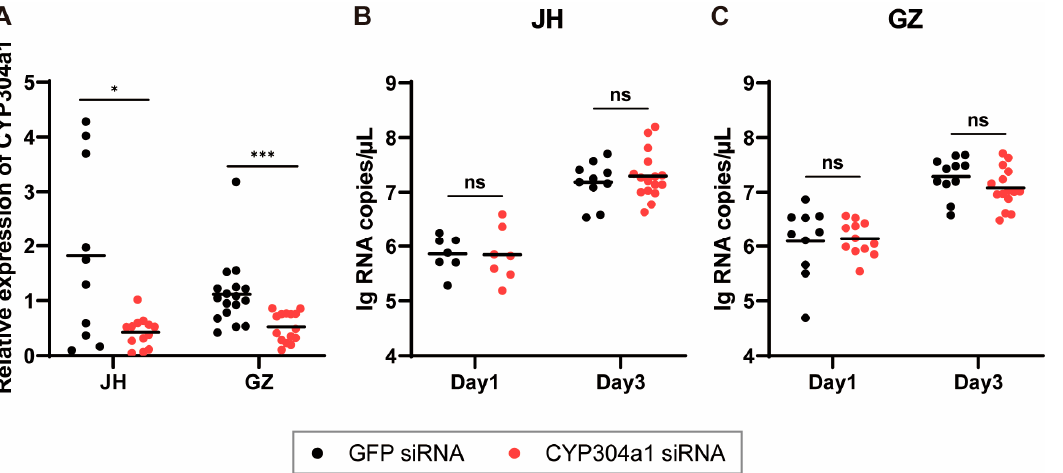
Figure 4. CYP304a1 silencing and ZIKV infection in Ae. albopictus . ( A ) Abundance of CYP304a1 after RNA interference. Mosquitoes were microinjected with GFP and CYP304a1 siRNA, and the relative expression of CYP304a1 in the mosquitoes was detected by RT-qPCR. One dot represents 1 mosquito, and the horizontal line represents the median of the results. Differences between two groups were compared by the non-parametric Mann–Whitney test. The siRNA knockdown efficiency of CYP3304 a1 in the JH and GZ strains was 65.5% and 53.5%, respectively. ZIKV RNA copies were in the Ae. albopictus JH ( B ) and GZ ( C ) strains. The ZIKV suspension was inoculated by thoracic microinjection at 3 days post-CYP304a1 silencing. The viral load was assessed at 1 and 3 dpi through RT-qPCR. One dot represents 1 mosquito, and the horizontal line represents the mean of the results. The data were analyzed by 2-way ANOVA with Šídák’s multiple comparisons test. * p < 0.05 and *** p < 0.001. ns, no significant difference.